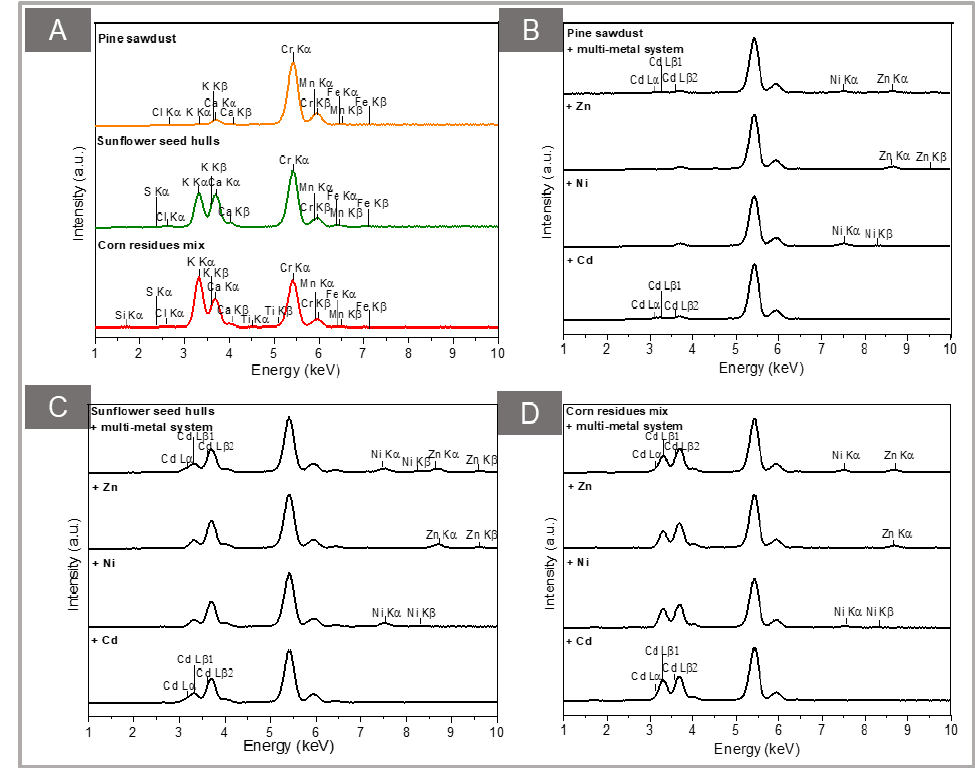
Figure 6. XRF of: ( A ) biomasses before the adsorption process, and after adsorption process with ( B ) pine sawdust, ( C ) sunflower seed hulls, ( D ) corn with adsorbed heavy metals.